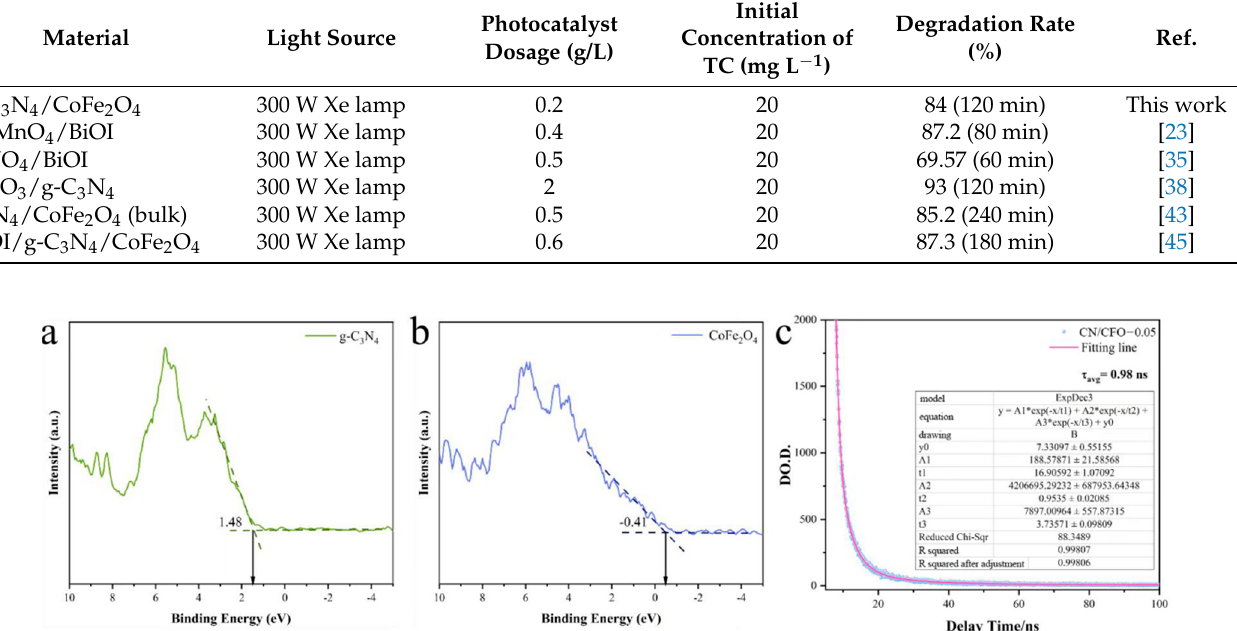
Table 3. Comparison of TC removal rates by different photocatalysts under 300 W xenon lamp irradiation.